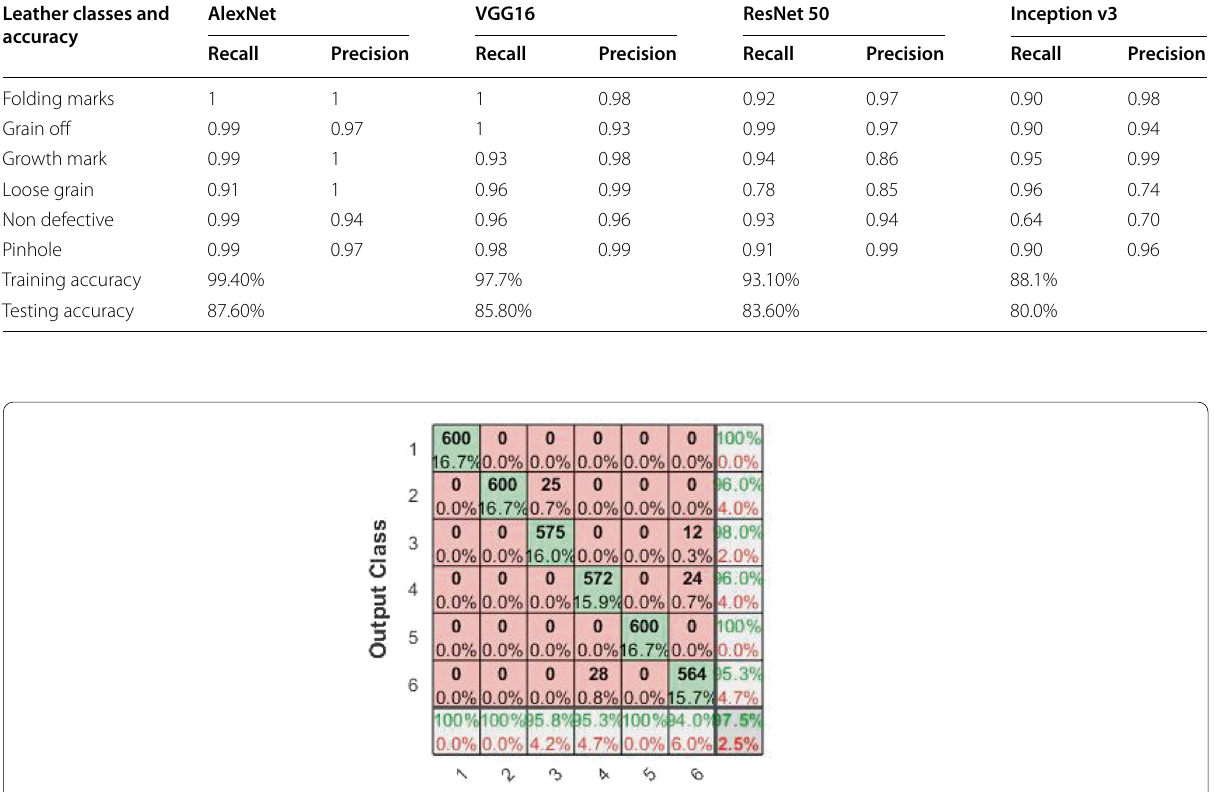
Table 5 Comparison of classification accuracy of deep learning neural networks Leather classes and accuracy